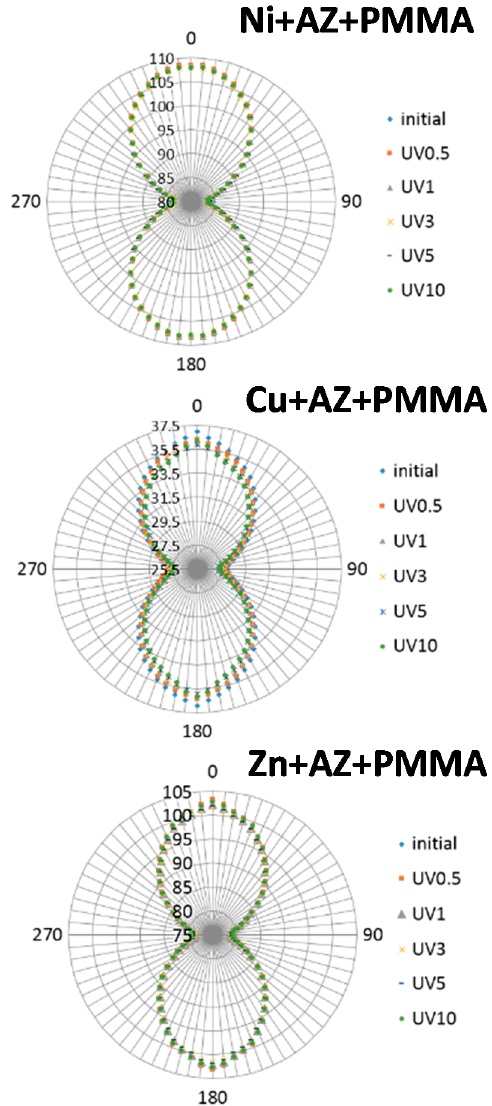
Figure 2. Angular dependence of polarized IR spectra (C=N bands at 1634, 1628, and 1617 cm − 1 ) after irradiation of linearly polarized UV light Ni+AZ+PMMA , Cu+AZ+PMMA , and Zn+AZ+PMMA , respectively.